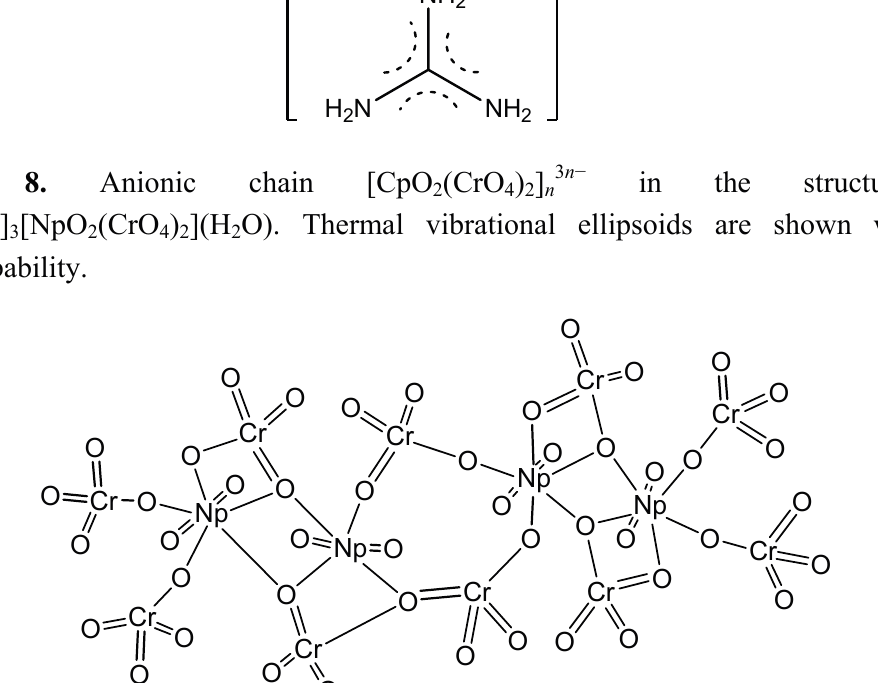
Figure 7. Guanidinium cation. NH 2